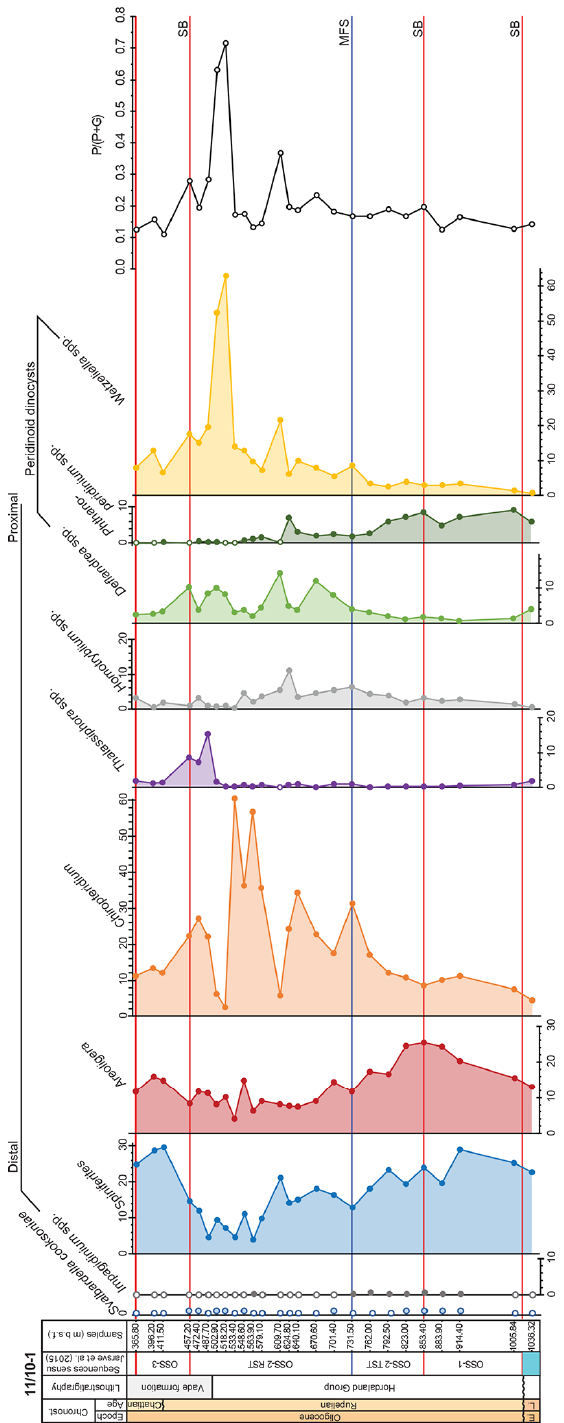
Figure 5. The relative abundance (%) of selected dinocysts groups recorded in the studied interval of the 11/10-1 well plotted against the sequence stratigraphic framework (Jarsve et al., 2015). Red horizontal lines marks sequence boundaries, and the blue line marks maximum flooding surface. All samples with “0” values are marked with dots with white